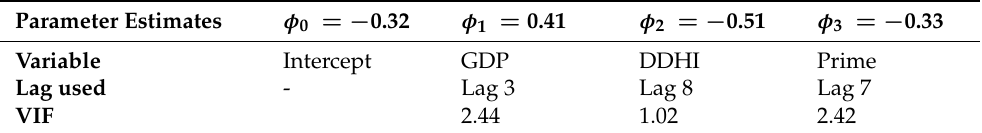
Table 2. Results for the short-term portion of the ECM.